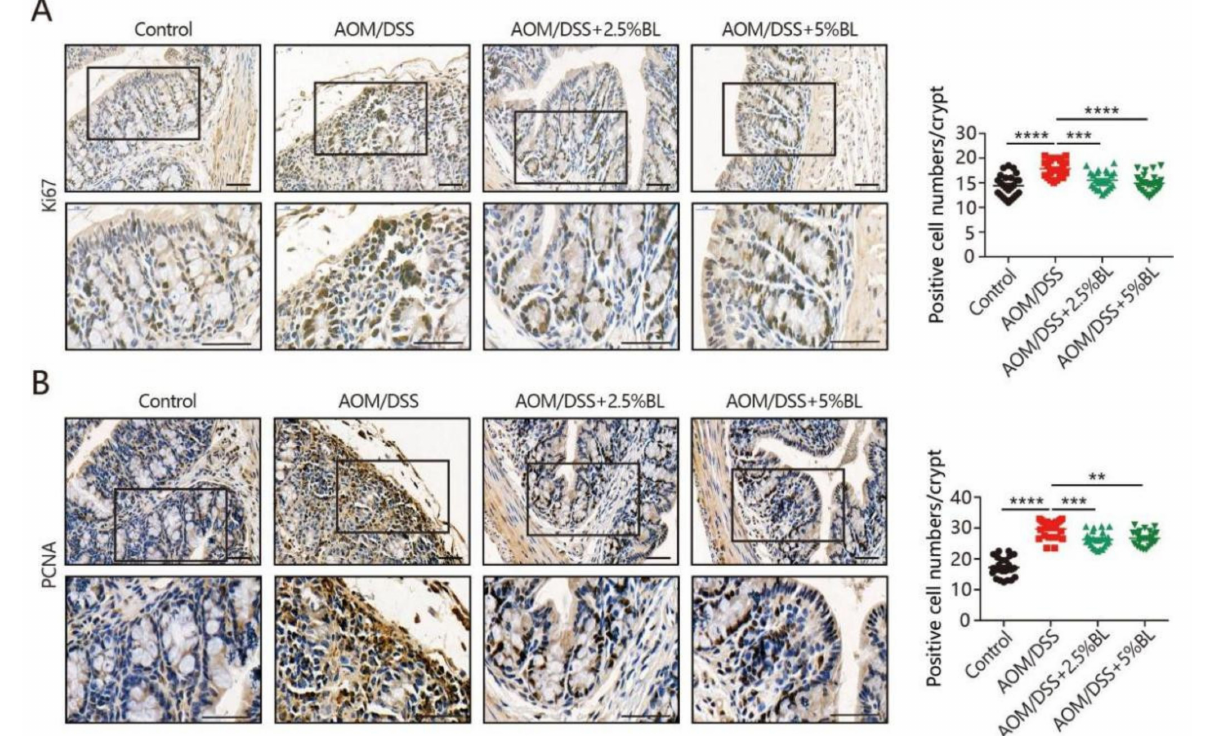
Figure 4. BL suppresses AOM/DSS-induced cell proliferation. ( A ) Immunohistochemistry analysis of Ki-67 in mouse colonic sections and positive cell numbers were quantified. Upper: (200 × ). Lower: (400 × ). ( B ) Immunohistochemistry analysis of proliferating cell nuclear antigen (PCNA) in mouse colonic sections and positive cell numbers were quantified. Upper: (200 × ). Lower: (400 × ). Data are mean ± SEM. ** p < 0.01, *** p < 0.001, and **** p < 0.0001. The statistics were performed with one-way ANOVA. BL, barley leaf; AOM, azoxymethane; DSS, dextran sodium